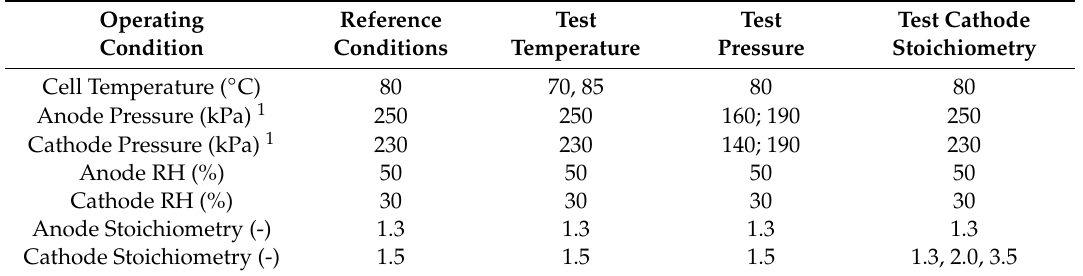
Table 1. Operating conditions defined for the fuel cell (according to the testing protocol